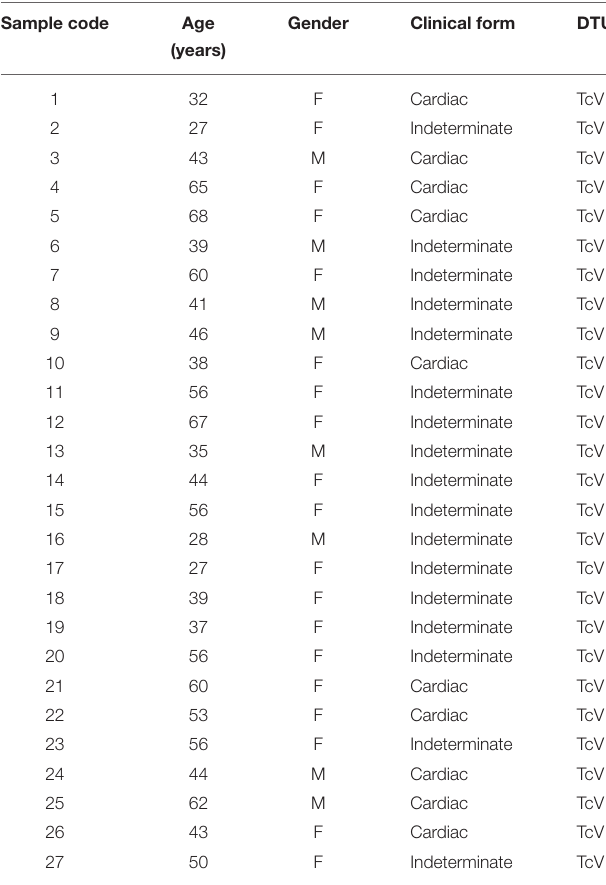
TABLE 1 | General information of patients with Chagas disease involved in the study.